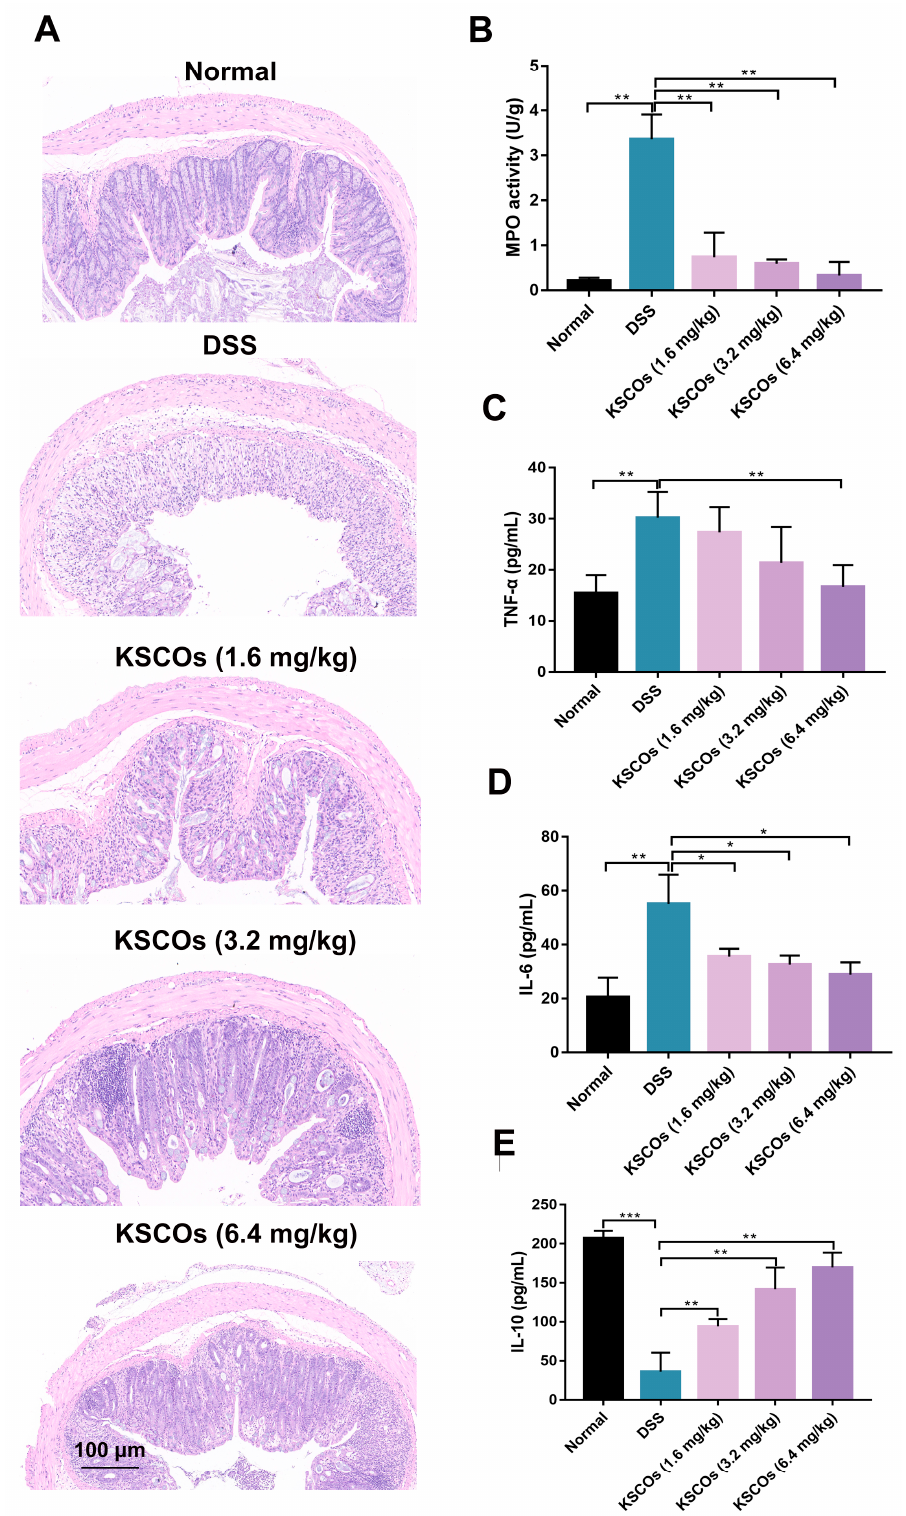
Figure 5. Effect of KSCOs on the histological injury, the activity of MPO in colon tissues and the level of inflammatory cytokines in serum with colitis: ( A ) H&E staining (scale bar = 100 µ m); ( B ) MPO activity; ( C ) the contents of TNF- α ; ( D ) the contents of IL-6; ( E ) the contents of IL-10. Data are shown as means ± SD, * p < 0.05, ** p < 0.01, *** p < 0.001.